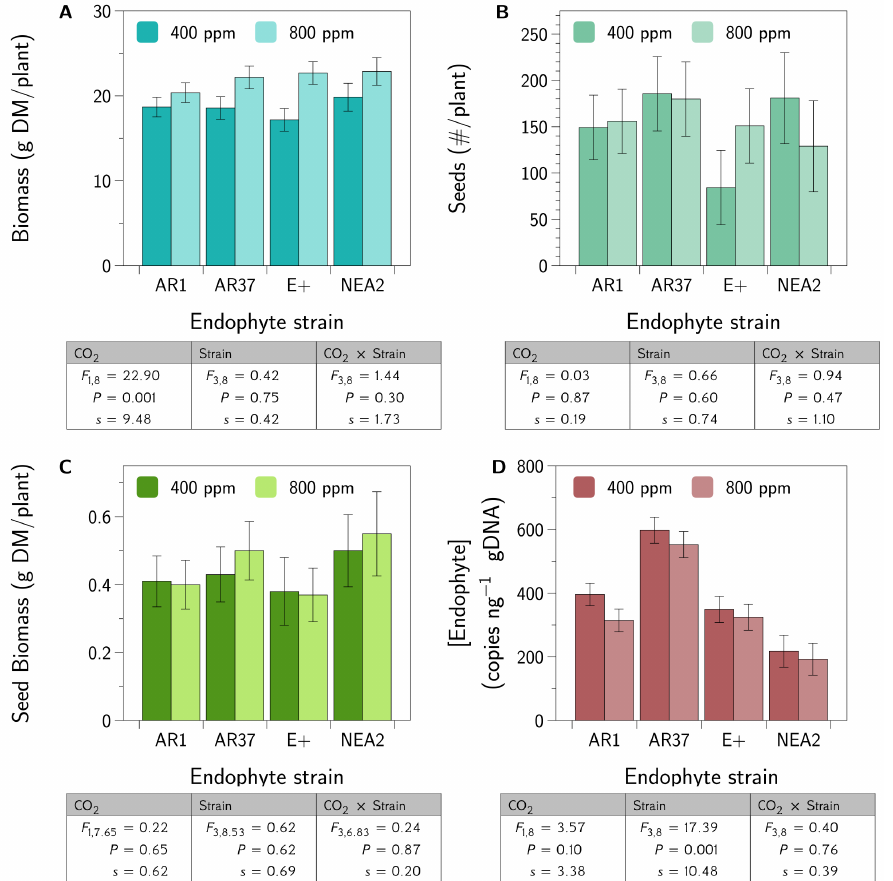
Figure 1. Plant growth responses—fixed effects. Shown are the fixed effects (LS Means ± SEM) from a REML analysis of the model Plant24(Family2–4(Strain4) [ CO 2 ] 2 ). Below each graph are the results